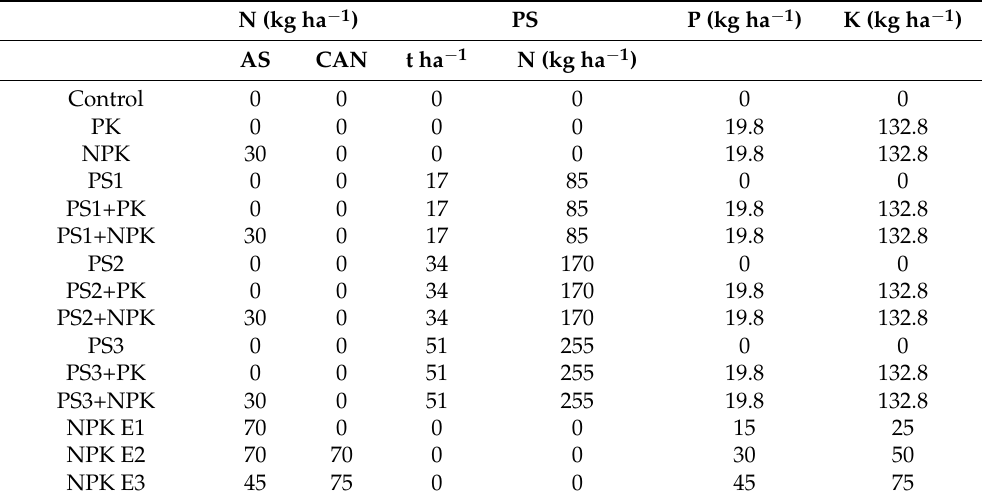
Table 2. Forms and doses of mineral fertilizers and pig slurry (PS) according to the fertilizer treatments applied to FP in